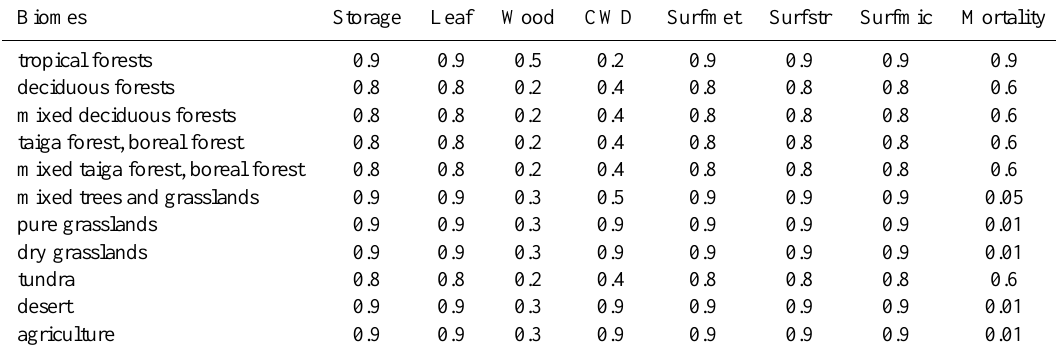
Table 1. Combustion completeness fractions for different biomes and carbon pools. The tree mortality fraction is given in the last column. Both quantities are chosen accordingly to represent the biome mean value. CWD stands for coarse woody debris, and surfmet, surfstr, and surfmic stand for surface metabolic, surface structural, and surface microbial, respectively.